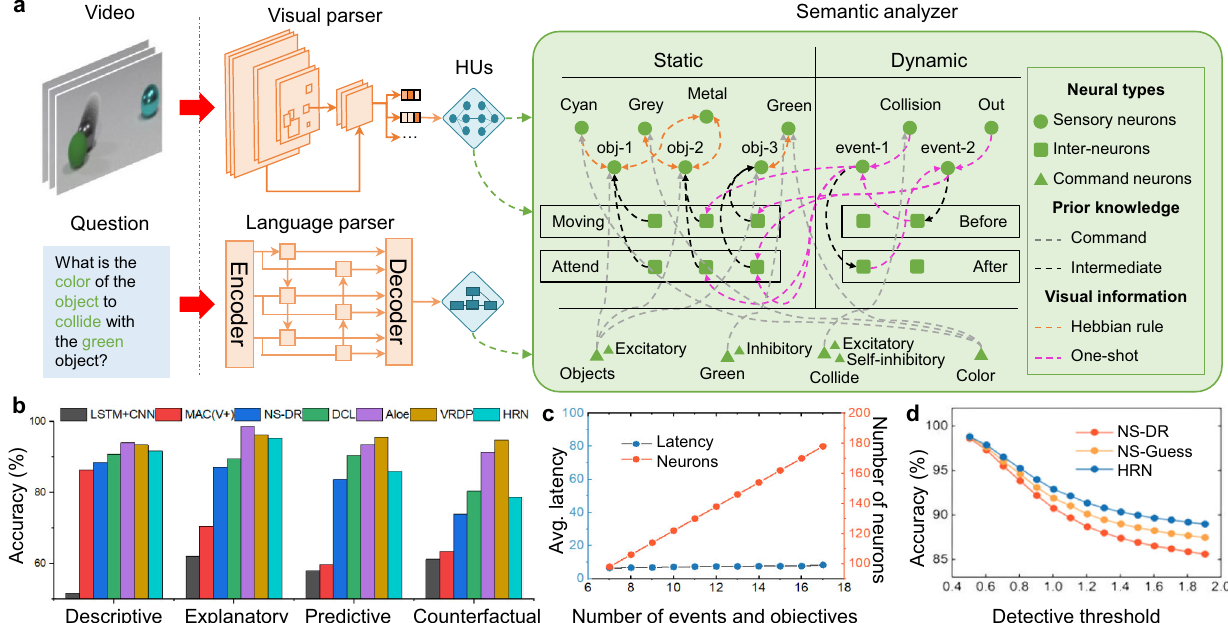
Fig. 4 HRN for VQA task. a Two ANN-based parsers extract vision and language features, and an SNN-based analyzer executes a two-phase process to construct a graph and reason with it. In the construction phase, the SNN is initialized with prior knowledge, and then the independently trained learnable HUs transmit visual information into spike trains, which activate sensory neurons and intermediate neurons simultaneously in the SNN to embed external information according to the Hebbian rule and one-shot plasticity. In the reasoning phase, designable HUs transmit language information into polychromous activations 52 activating command neurons to execute the reasoning process. b The accuracy of the CLEVRER validation set according to different task types. The reasoning results are compared with CNN-LSTM 35 , MAC(V + ) 36 , NS-DR 37 , DCL 38 , Aloe 39 , and VRDP 40 , respectively. c The plot of calculation latency and the number of spiking neurons against the increase of target objects. d Reasoning robustness to the frontend anomaly